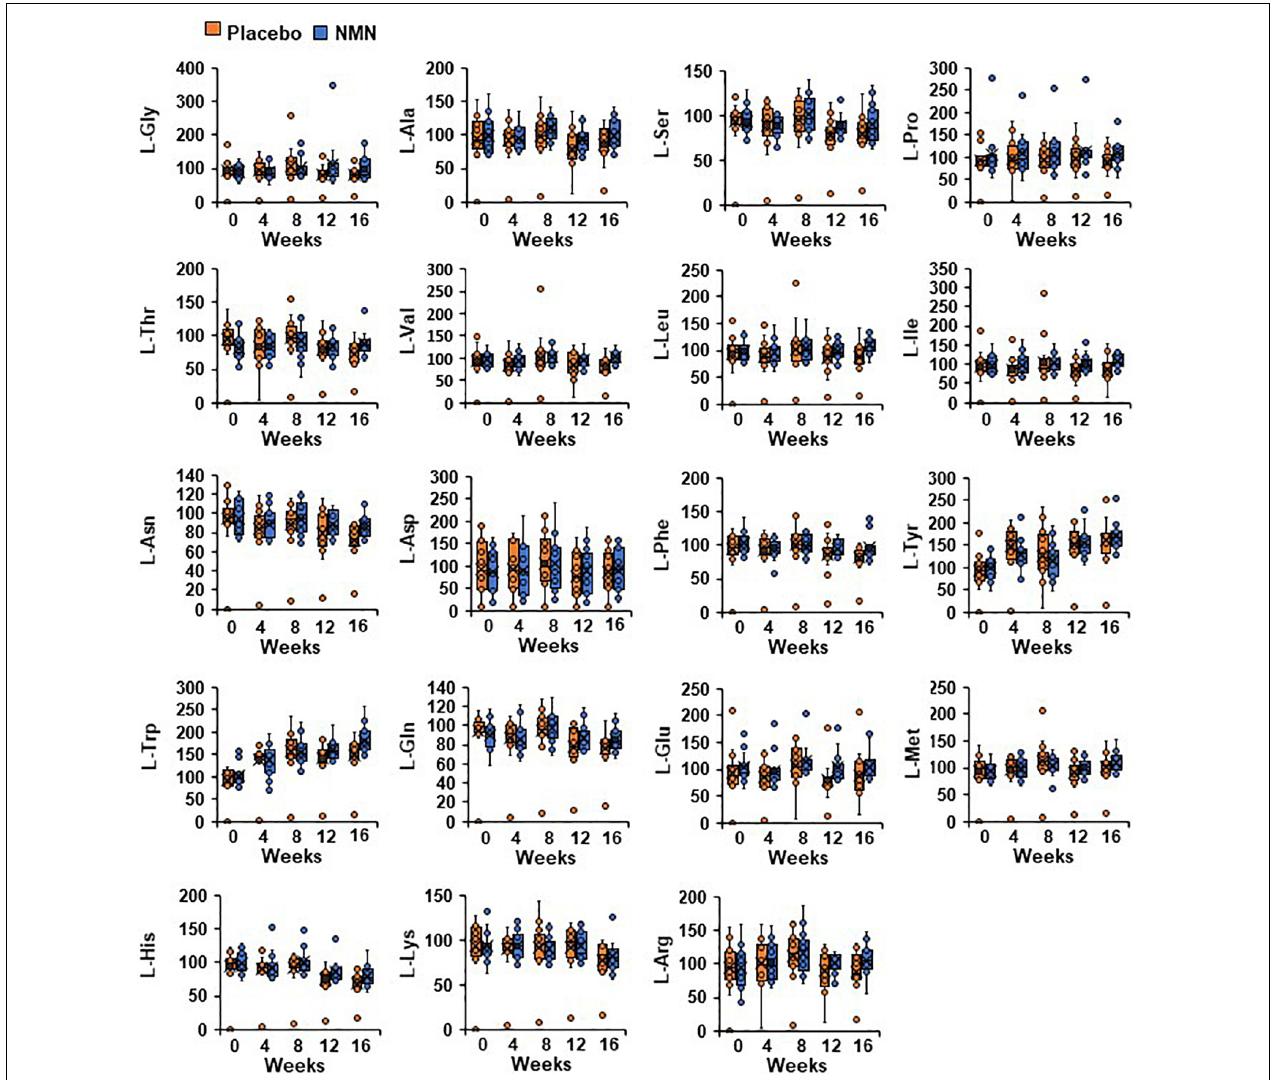
FIGURE 7 | Oral NMN treatment had little effect on blood amino acid levels. Amino acid metabolome in blood was measured every 4 weeks. Amino acid metabolome in each time point was showed in box plots. In the box plots, the median is indicated by the line within the boxes. The lower and upper boundaries of the boxes indicated 25th and 75th percentiles. The upper and lower lines above and below the boxes represent the whiskers. Orange boxes represent placebo group ( n = 15 at 0, 4, 8 weeks, n = 14 at 12, 16 weeks) and blue boxes represents NMN group ( n = 15).